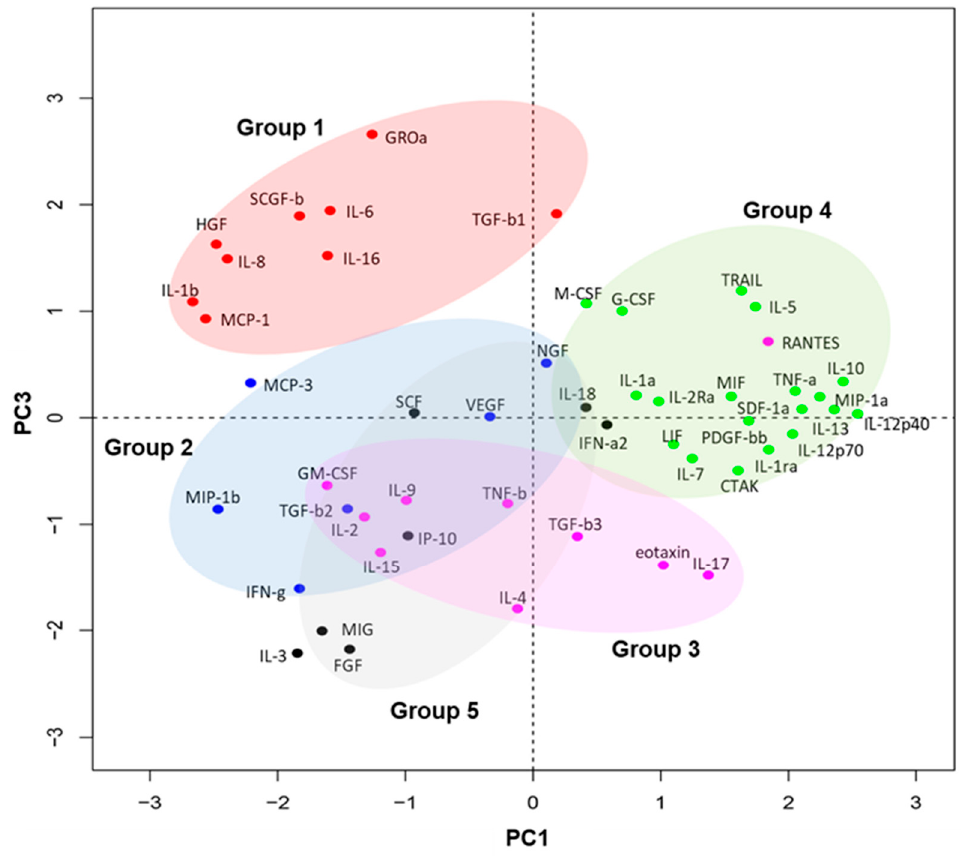
Figure 1. Five groups of soluble factors as classified by the kinetics in tear protein expression following EK. To enable visualization of groups of factors that displayed similar profiles of change over the course of transplantation, we implemented dimensionality reduction and a clustering algorithm. The mean of each of the 51 tear-soluble factors was calculated and normalized amongst the 21 patients using Z-score normalization for each time point (D0, D1, W1, M1). Principal component analysis was then conducted on the standardized time-point factors. The most informative clustering was visualized when PC1 and PC3 components were mapped onto a biplot (cumulative variance = 49.72%), and clustering was conducted with partitioning around medoids with the number of clusters estimated by optimum average silhouette width. The five clusters are color-coded (Details in the Experimental Section).